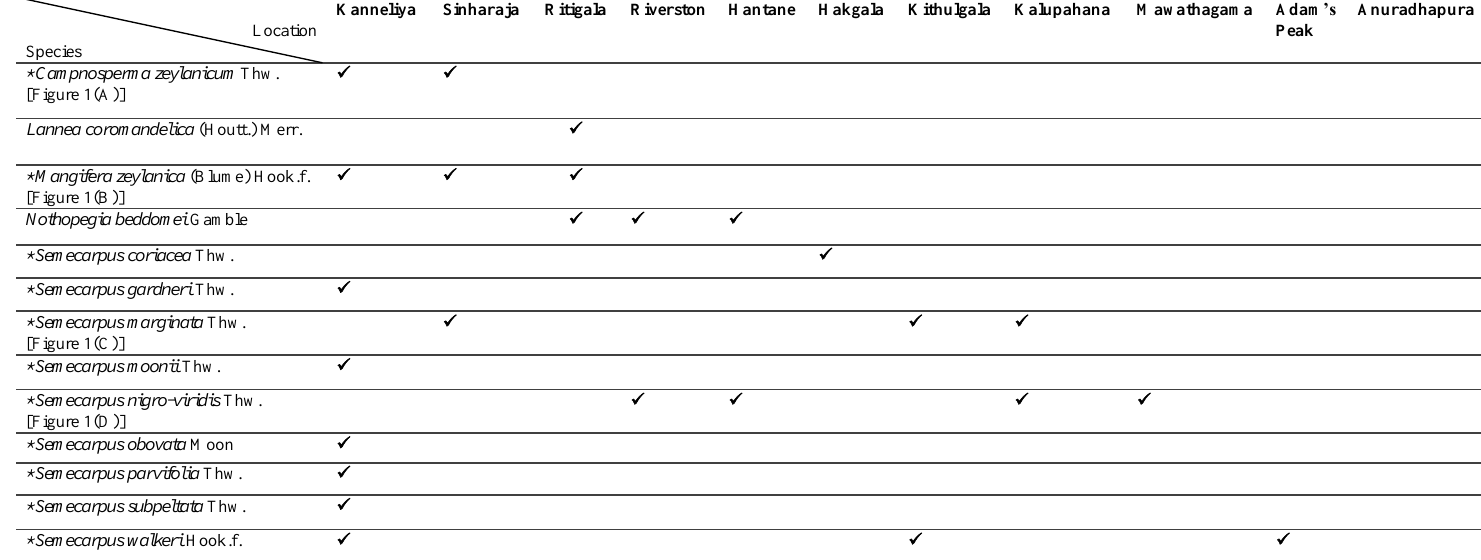
Table 1: Occurrences of different Anacardiaceae species encountered during the study. Endemics are indicated by an